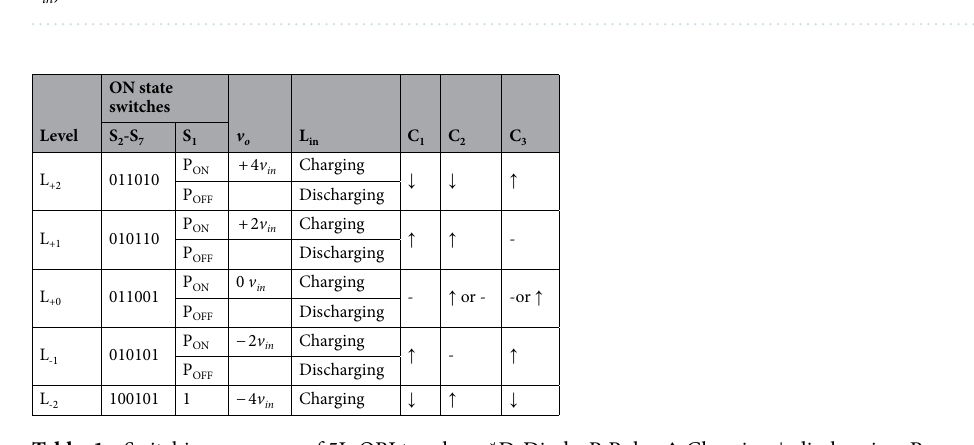
Figure 2. Modes of operation ( a ) L +2 (+ 4 v in ), ( b ) L +1 (+ 2 v in ), ( c ) L 0 (+ 0 v in ), ( d ) L −1 (−2 v in ), and ( e ) L −2 (−4 v in ).